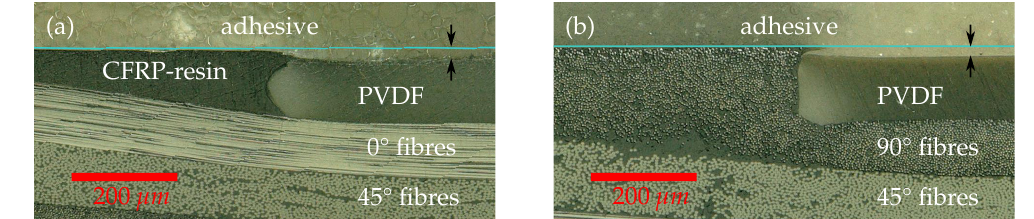
Figure 12. Cross section view of CFRP layers with polymer inlay. A light blue line is introduced to indicate the surface level of the CFRP material. Although the PVDF inlay was pressed flush with the Caul plate into the prepreg, a shrinkage step of about 25µm, marked by arrows, occurs when the cured CFRP plate cools down due to the different coefficients of thermal expansion. ( a ) Upper layer orientation is 0°. ( b ) Upper layer orientation is 90°.